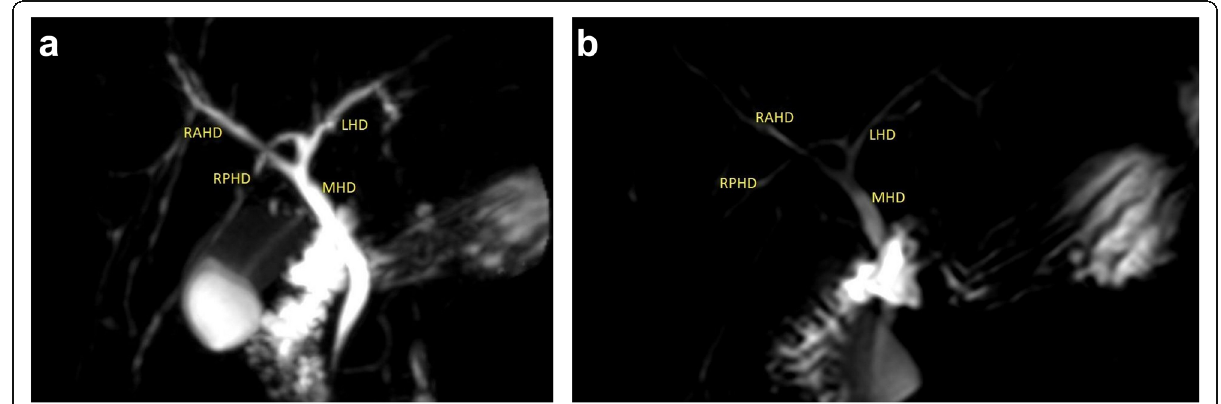
Fig. 5 MRC 3D TSE ( a ) and MRC (RARE) ( b ). Huang type A3: RPHD opens into LHD (RPHD, right posterior hepatic duct; RAHD, right anterior hepatic duct; LHD, left hepatic duct; and MHD, main hepatic